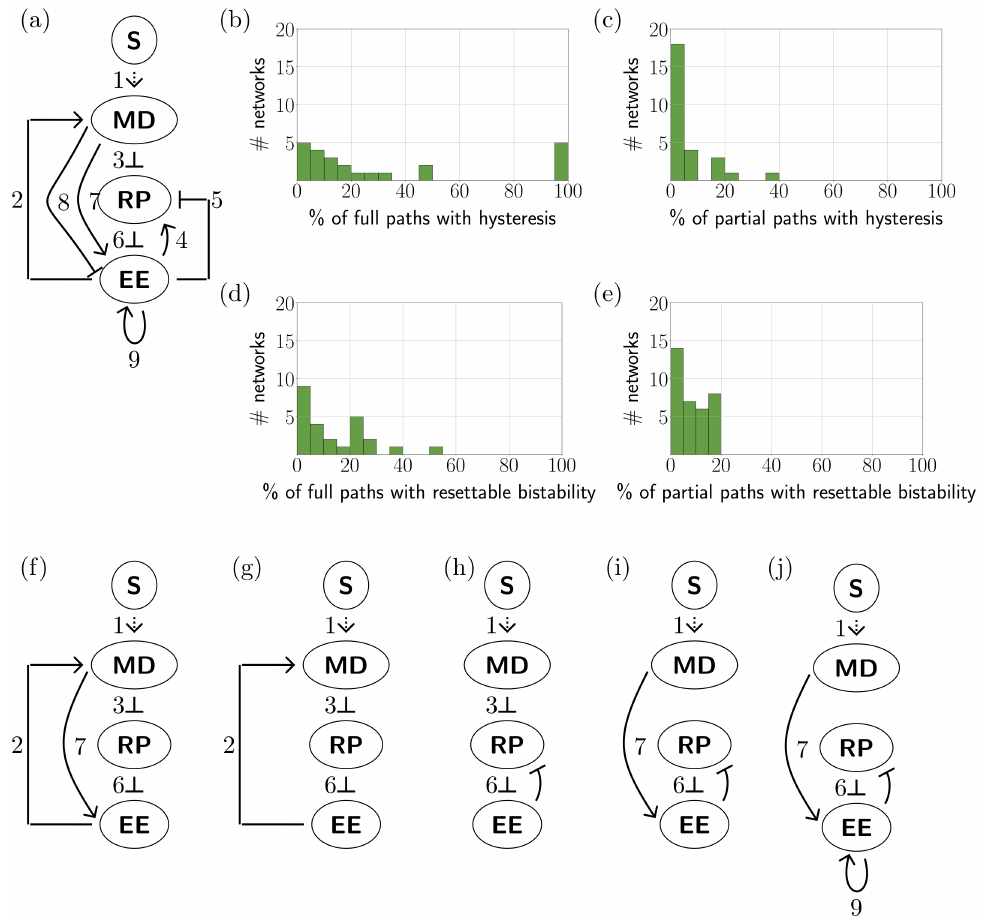
Fig 3. 3 node E2F-Rb networks. (a) 3 node network with potential edges from [4] with signal S acting on MD . (b) Histogram showing 24 regulatory networks expressing full path hysteresis between QS and PS. Five regulatory networks show full path hysteresis in 100% of EPG ( ¬ MD ). (c) Histogram showing 27 regulatory networks expressing partial path hysteresis between QS and PS. (d) Histogram showing 25 regulatory networks expressing full path resettable (QS,PS) bistability to QS. (e) Histogram showing 35 regulatory networks expressing full path resettable (QS,PS) bistability to QS. (f)-(j) Five networks that exhibit full path hysteresis along all appropriate paths in EPG ( ¬ MD )These networks are also the top five networks in partial path hysteresis in descending order (f),(g)-(i), (j). Network (f) is also highest in prevalence of partial path resettable bistability, but does not show any full path resettable bistability. Full results for all networks can be find in S1 Table, where the five networks (f)-(j) have numbers 24,39,46,26 and 22.